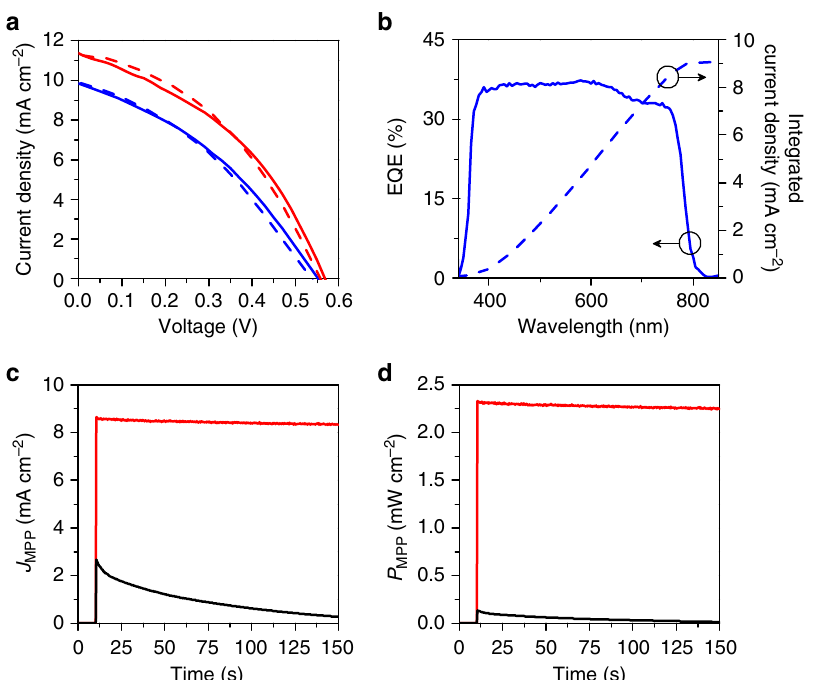
Fig. 3 Photovoltaic properties of self-assembled monolayer modi fi ed back-contact perovskite solar cells. a J – V curves of a dipole-modi fi ed gold-perovskite- gold bc-PSC measured under standard solar irradiation (AM 1.5 G, 1000 W m − 2 ), reverse scan ( solid blue , encapsulated; solid red , unencapsulated) and forward scan ( dashed blue , encapsulated, dashed red , unencapsulated). b Spectral response (External quantum ef fi ciency – EQE, solid line ) and the corresponding integrated short-circuit current density (dashed line) of a SAM-modi fi ed PSC. c Time evolution of the maximum power point photocurrent density ( J MPP ) of a SAM-modi fi ed ( red ) and poled, unmodi fi ed bc-PSC (black) and their power output